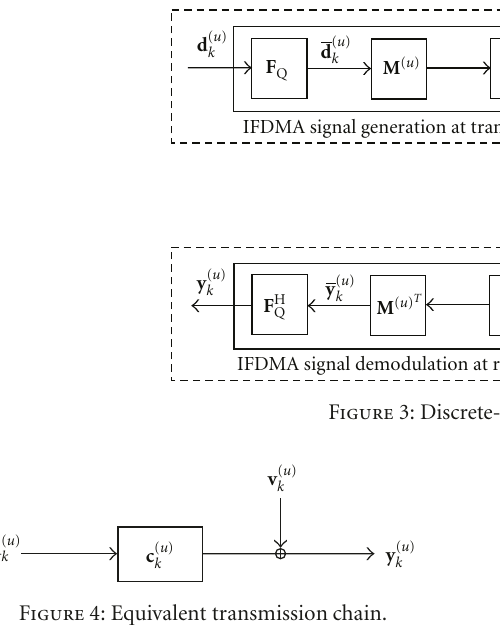
Figure 4: Equivalent transmission